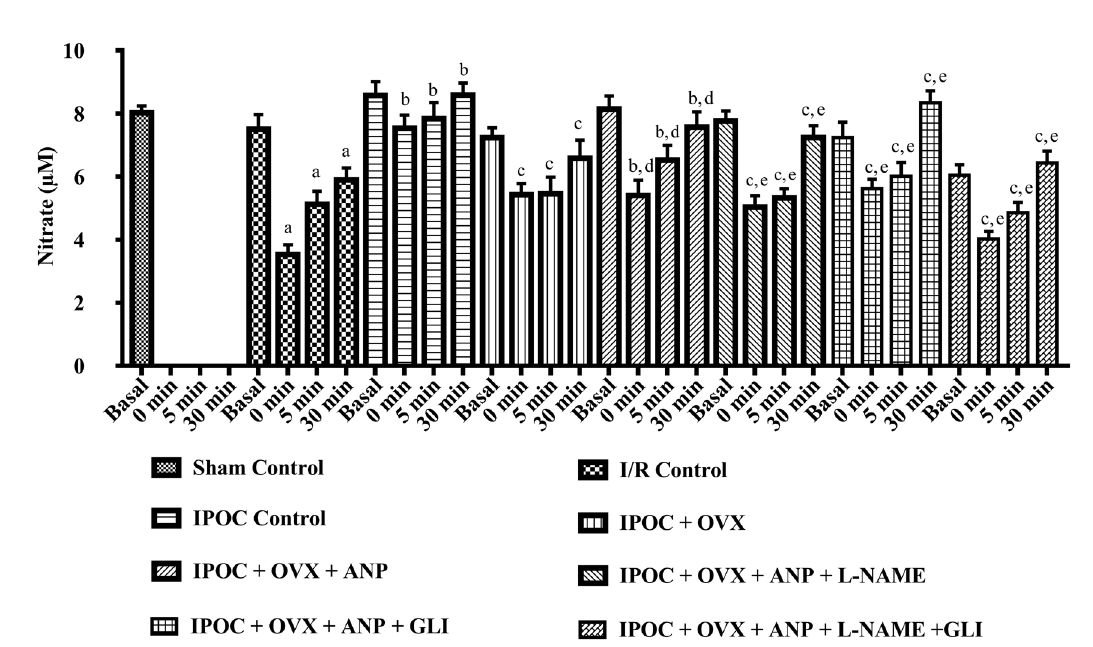
FIGURE 11 - Effect of I/R on heart rate, effect of IPTC on heart rate in normal and OVX rat heart, effect of ANP perfusion, effect of L-NAME and ANP perfusion, effect of Glibenclamide and ANP perfusion and effect of L-NAME, Glibenclamide and ANP perfusion on heart rate in OVX rat